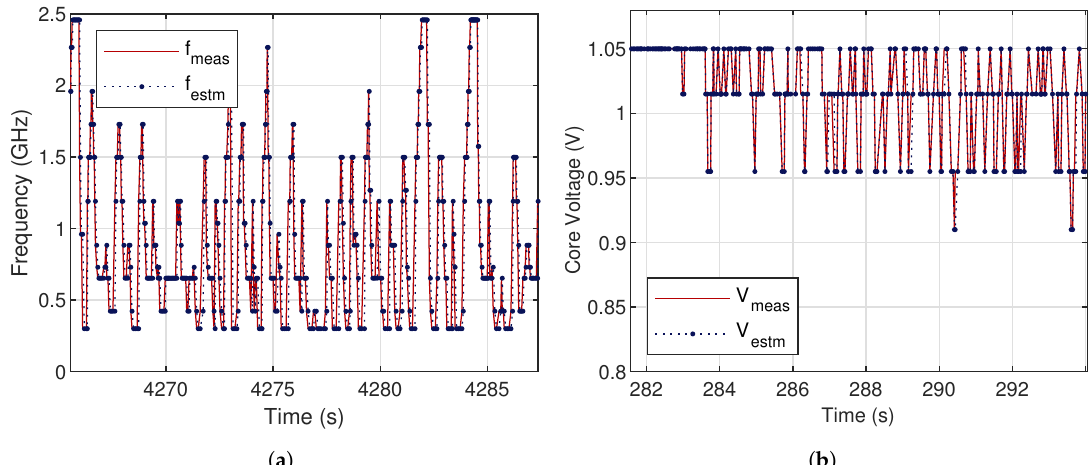
Figure 8. Frequency and voltage models performances. ( a ) Frequency model estimations vs. system readings. ( b ) Voltage model estimations vs. system readings.